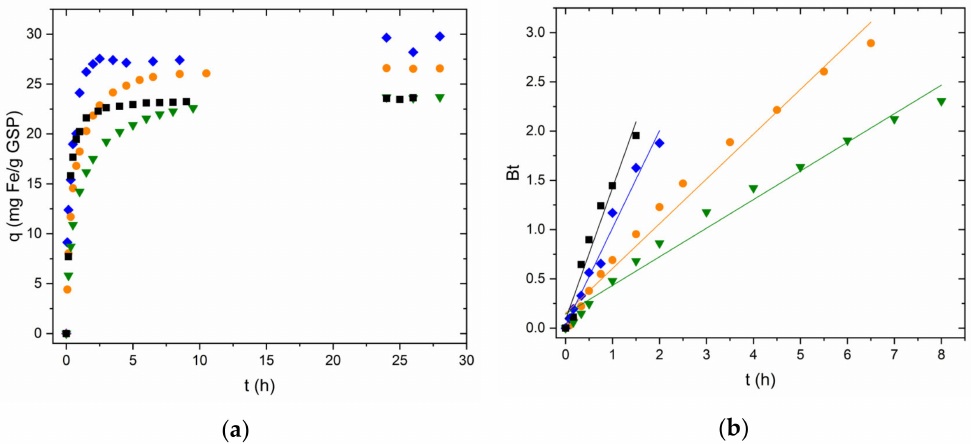
Figure 5. ( a ) Fe(II) adsorption kinetics using GSP S-1 (initial Fe(II) concentration: (cid:72) 50 mg · L − 1 ; • 80 mg · L − 1 ; (cid:7) 275 mg · L − 1 ) and S-0.5 ( (cid:4) , initial Fe(II) concentration 80 mg · L − 1 ). ( b ) Application of